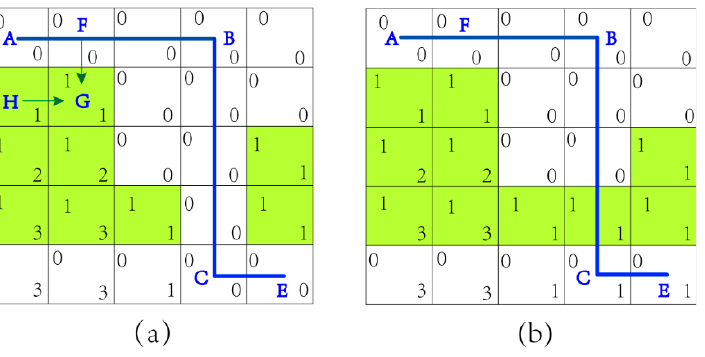
Figure 11. Valid binary map and invalid binary map: ( a ) valid binary map, ( b ) invalid binary map.